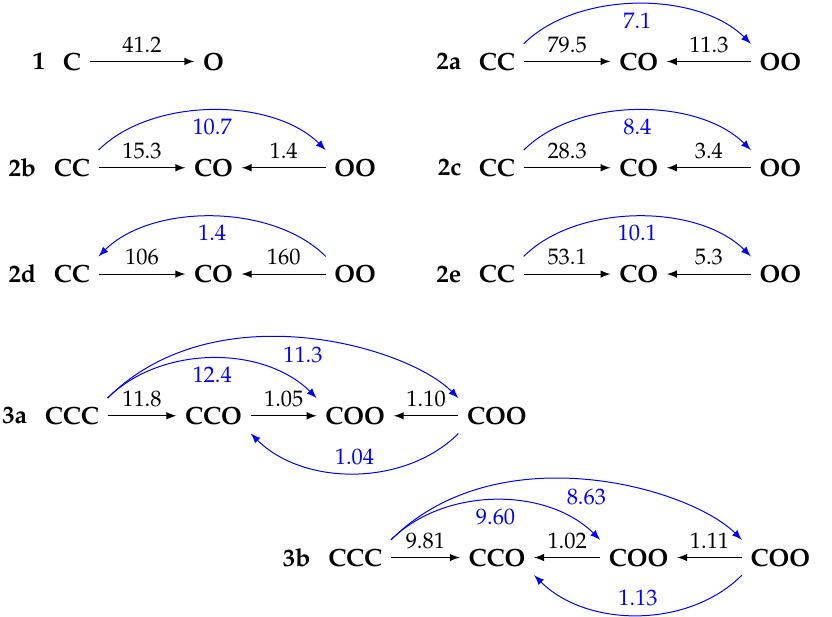
Figure 6. Contrasts of dynamic (at 1907nm) first hyperpolarizability (given on the arrows by β ( end ) / β ( start ) ) of the compounds in their different forms, as evaluated at the TDDFT/M06-2X/6- 311+G(d)/IEF-PCM (acetonitrile) level of approximation. The blue arrows are obtained by transitivity. These are averaged values using the MB populations at 298.15K as calculated at the ω B97X-D/6- 311G(d)/IEF-PCM (acetonitrile) level of